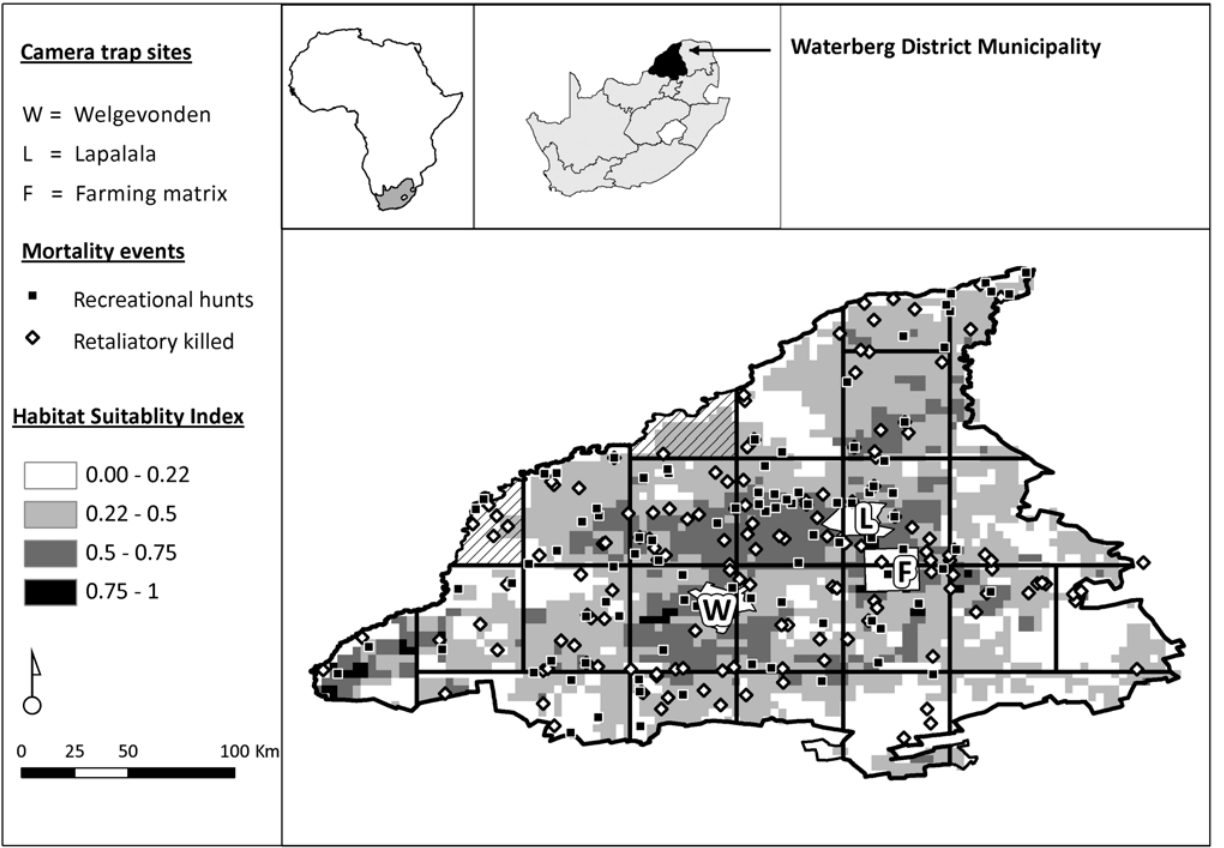
Fig 1. Predicted probability of leopard presence as estimated by a MaxEnt model, distribution of leopards killed in retaliatory incidents, leopard trophy hunts and camera trapping study sites in the Waterberg District, Limpopo Province, South Africa. Striped grids represent grid blocks excluded from analysis because sampling area was below our minimum sample area criteria. MaxEnt model taken from Swanepoel et al.